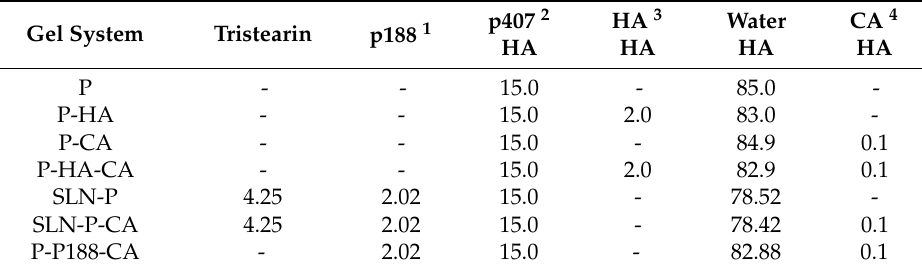
Table 3. Composition (% w / w ) of the indicated